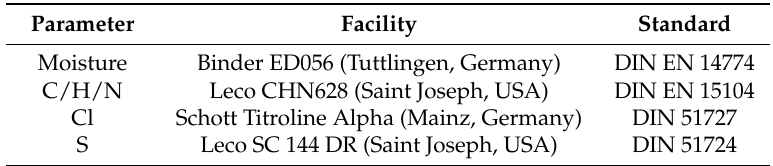
Table 1. Facilities and standards for the moisture and ultimate composition tests.